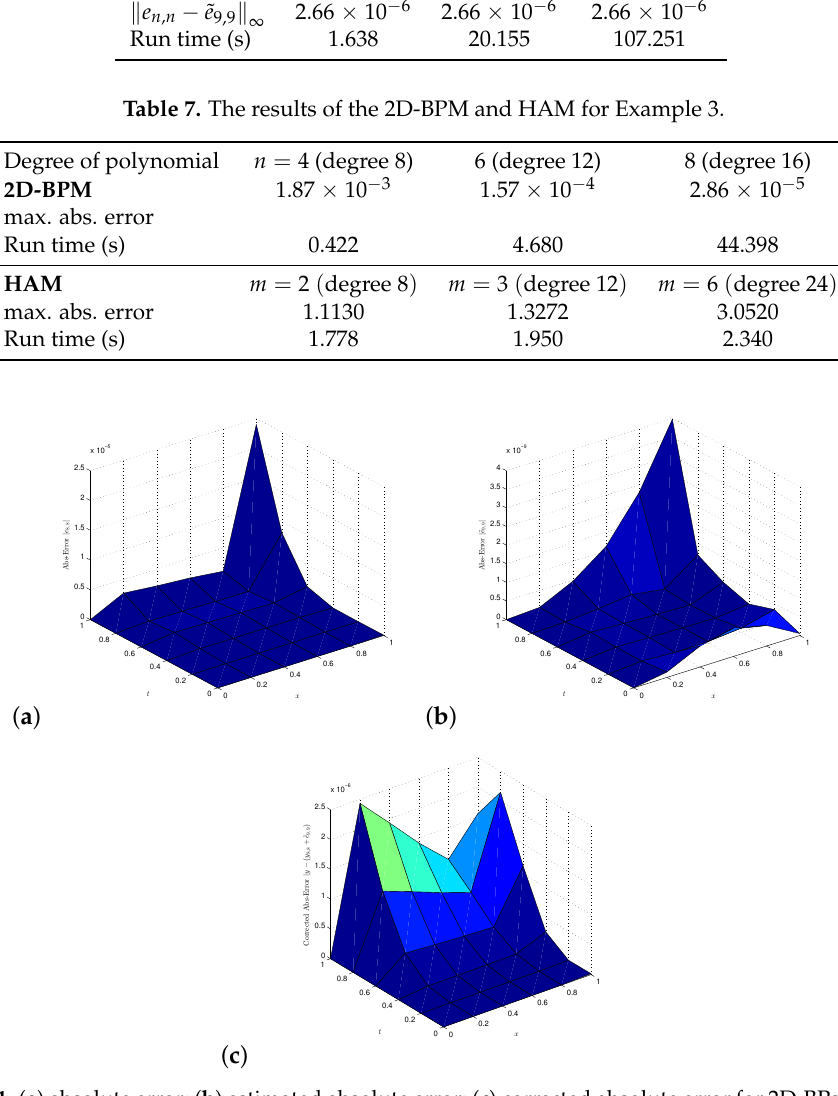
Figure 4. ( a ) absolute error; ( b ) estimated absolute error; ( c ) corrected absolute error for 2D-BPs solution for Example